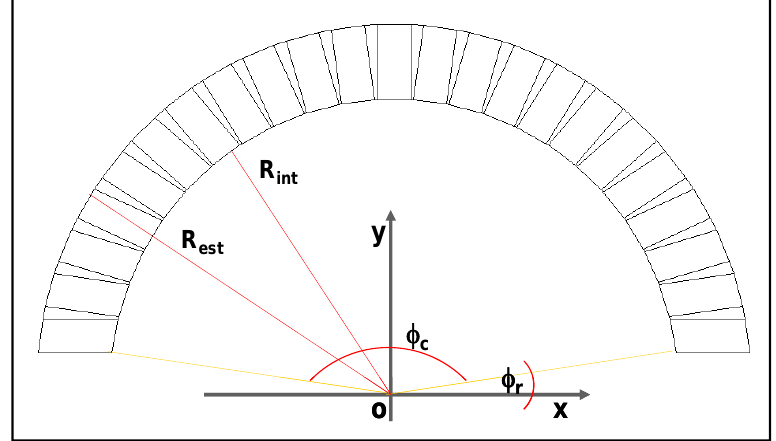
Figura 9: Modello geometrico